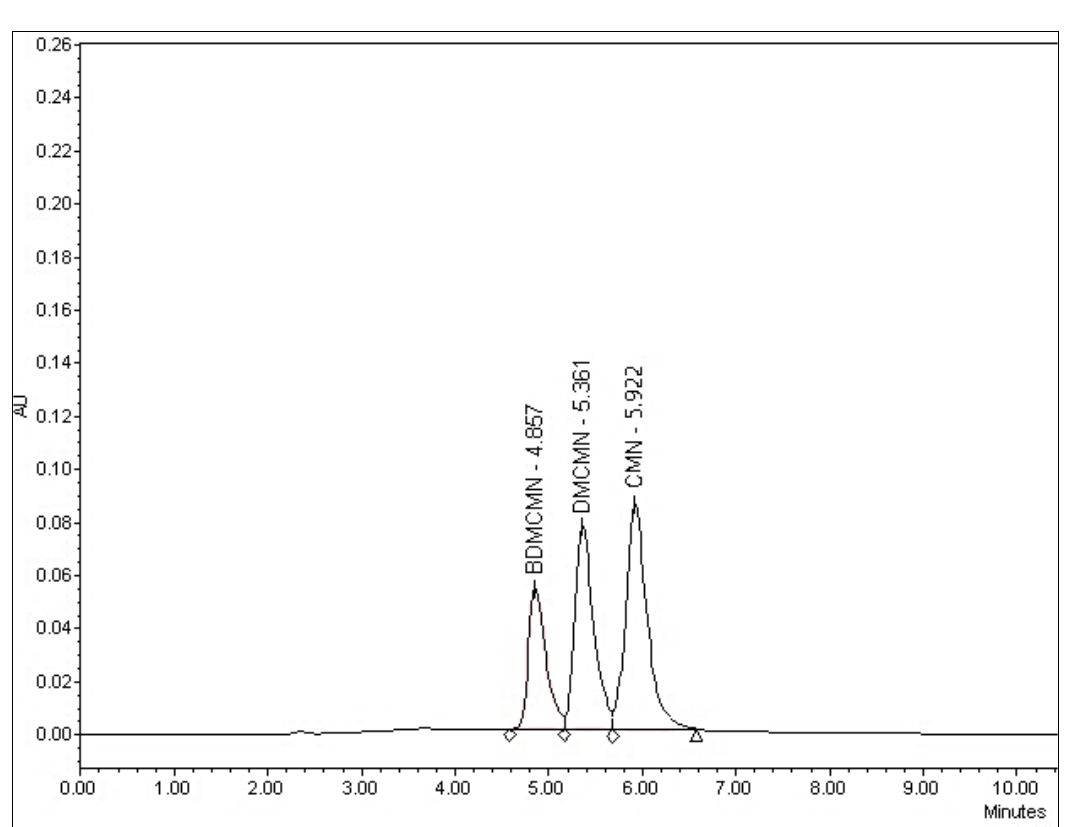
Figure 6. HPLC chromatogram obtained under the optimum conditions. Table 5. The experimental plan and responses of the Plackett–Burman design for robustness